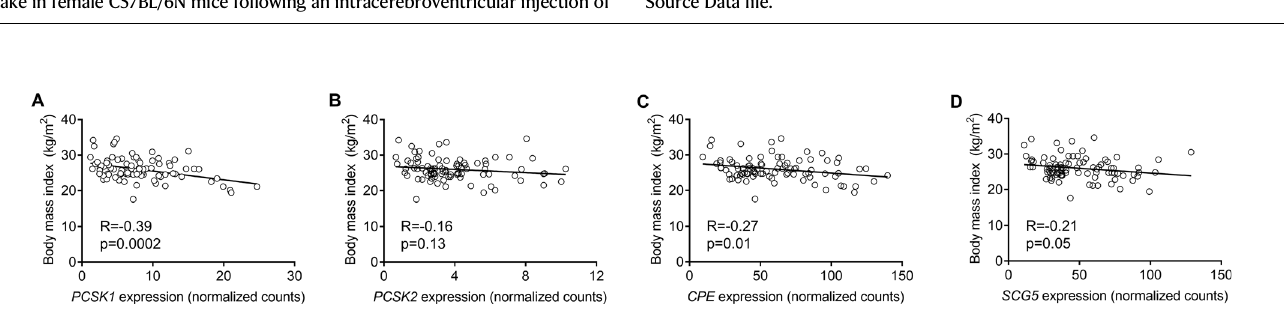
Fig. 5 | Incompletely processed proinsulin crosses the blood – brain barrier but does not induce central satiety. A , B Blood glucose concentrations ( A ) and food intake(averageof2micepercage)( B )2weeks(10 – 11weeksofage)postinduction in mice transplanted with insulin pellets or blanks 1 week after the fi rst tamoxifen dose. C Circulating and cerebrospinal fl uid levels of proinsulin-related peptides (isolated from the same mouse) in mice at various ages. D 20h cumulative food intake in female C57BL/6N mice following an intracerebroventricular injection of